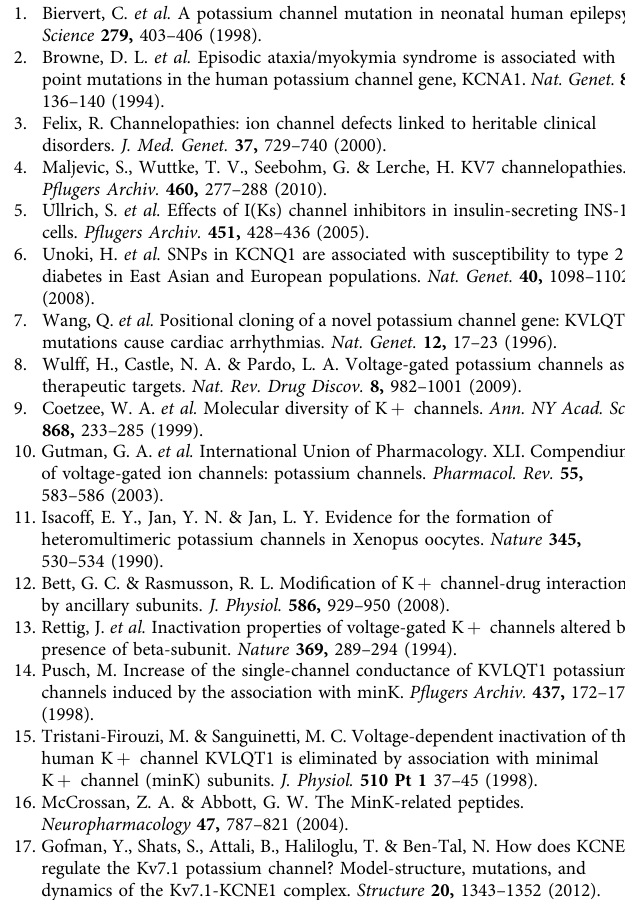
protocol used to simulate the traces shown in the figure was: holding